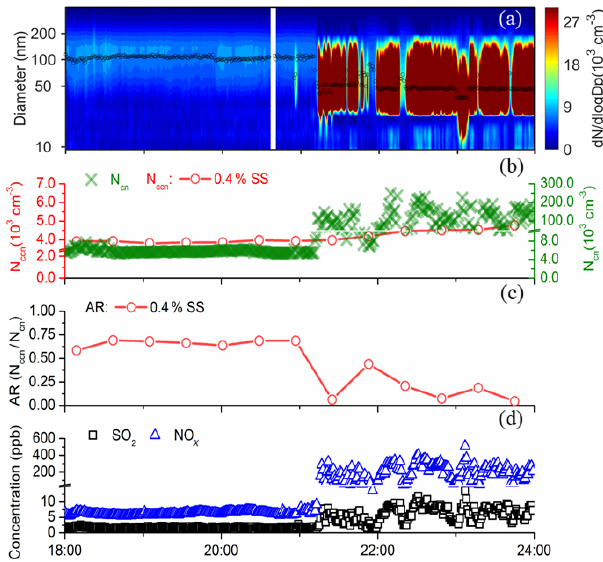
Figure 2. (a) Contour plot of particle number size distribution with the median mobility mode diameter shown in black hollow cir- cles; (b) time series of per minute N cn and half-hourly N ccn at SS = 0.4%; (c) half-hourly AR values at SS = 0.4%, (d) SO 2 and NO x at nighttime on DOY 115.